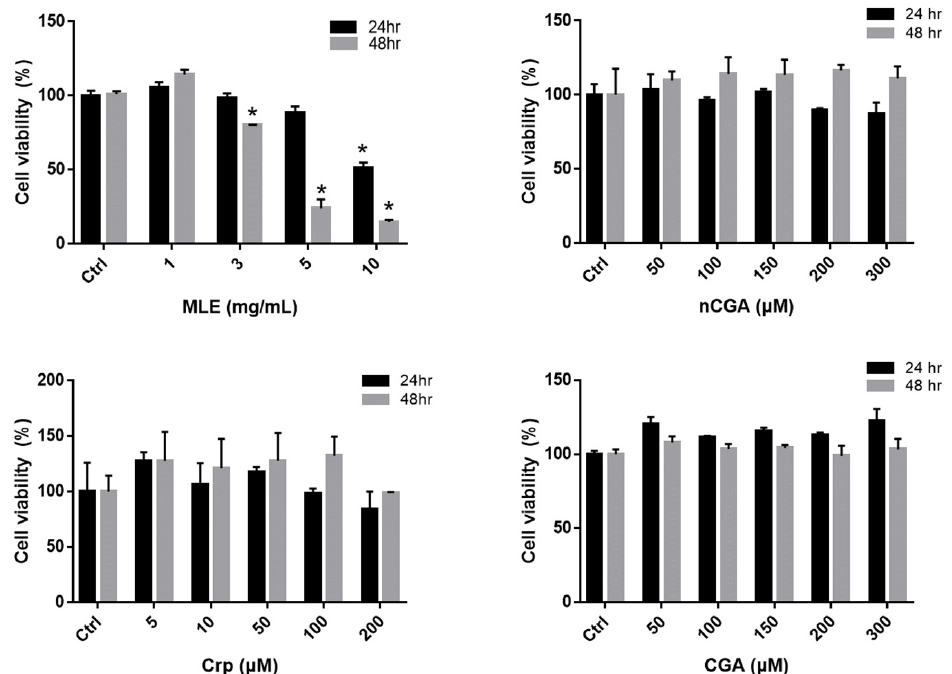
Figure 1. HepG2 cells were treated with different concentrations of MLE (1.0, 3.0, 5.0, and 10.0 mg/mL) and nCGA, Crp and CGA (0, 50, 100, 150, 200 and 300 µ M) for 24 and 48 h. Determine the cell viability of HepG2 cells by the MTT assay. Values are the mean ± SD of three replicates per treatment. * p < 0.05 vs. the control group.